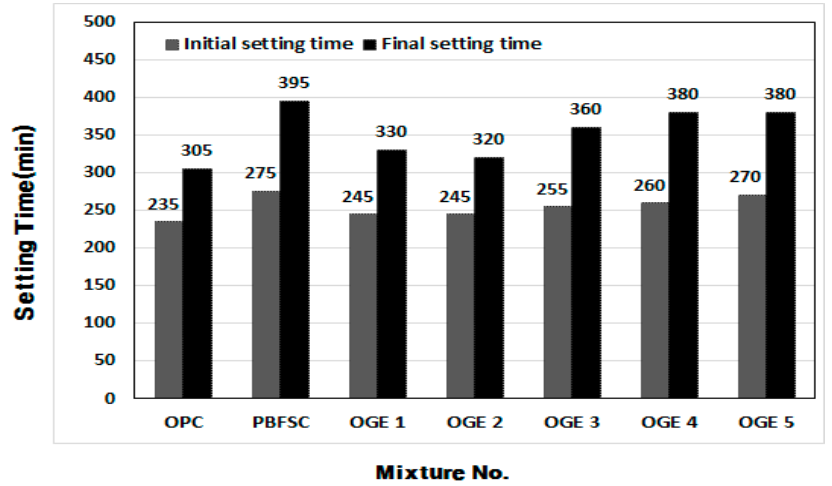
Figure 8. Setting time of OGE at different ESA burning temperatures.